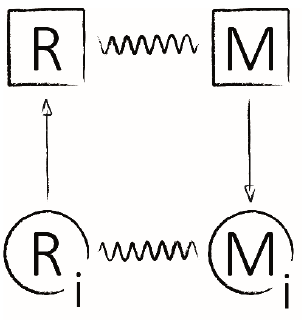
Figure 2. Schematic model of rhodopsin states and their conversions. Simplified cycle of theoretical state conversions of rhodopsin during photoactivation (R to M), deactivation (M to M i ) and regeneration (M i to R i to R). Sinus waves represent photoconversions (R to M, M to R, M i to R i and R i to M i ), arrows depict metabolic reactions (M to M i and R i to R). Adapted from [26].